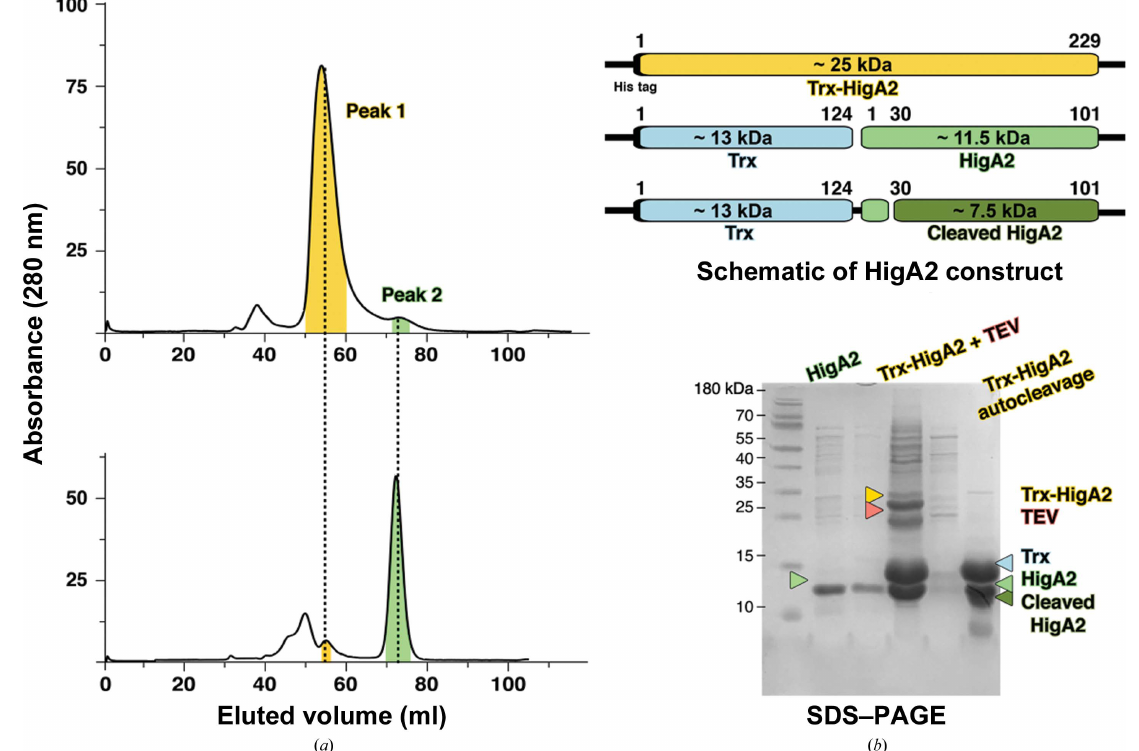
Figure 2 Autocleavage of Mt HigA2. ( a ) Size-exclusion chromatography of Mt HigA2 before (top) and after (bottom) TEV cleavage. The major peak coloured yellow reduces substantially, and a small peak shown in green became the major peak after purification. ( b ) Schematic diagram of Mt HigA2 and the corresponding SDS–PAGE. The colours correspond to the components in the Mt HigA2